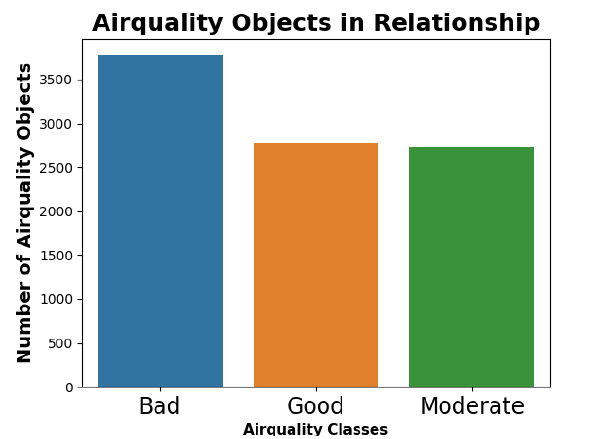
Figure 12. Air quality objects in relationship.